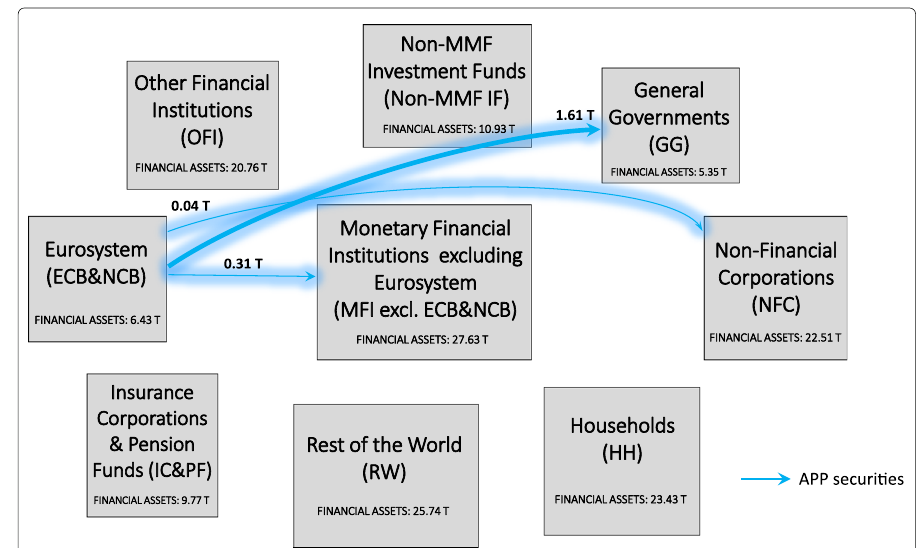
Fig. 7 The euro area macro-network of financial exposures via APP securities; June 2017. The macro-network of financial exposures among the different institutional sectors operating in the euro area (i.e., Eurosystem (ECB&NCB), Monetary Financial Institutions excluding the Eurosystem (MFI excl. ECB&NCB), Other Financial Institutions (OFI), Non-MMF Investment Funds (Non-MMF IF), Insurance Corporations and Pension Funds (IC&PF), Households (HH), Non-Financial Corporations (NFC), and General Governments (GG)), and the Rest of the World (RW), via private and public debt securities purchased within the APP (represented with light blue links), with reference to the second quarter of 2017. Weights represent the outstanding financial exposures of